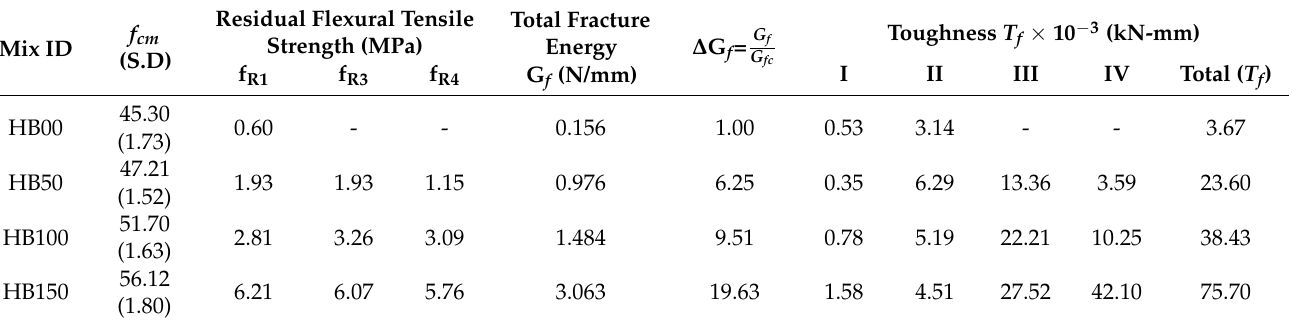
Table 3. Summary of material characteristics of